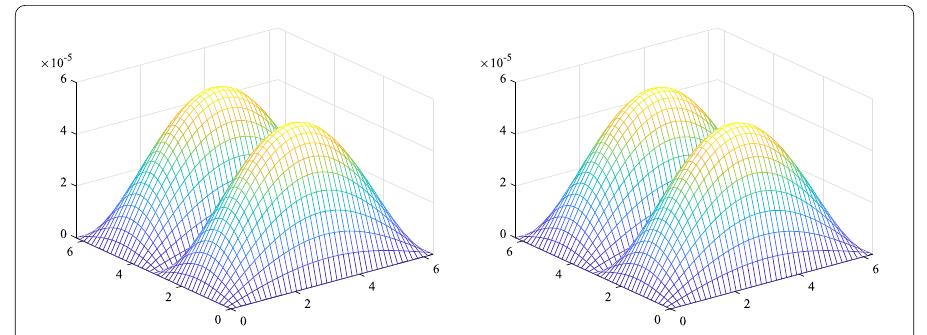
Figure 12 The error of CFDS6-SSM (left-hand side) and E-CFDS6-SSM (right-hand side) when J = 41, z = 0.4 π and t = 2 for SP 4